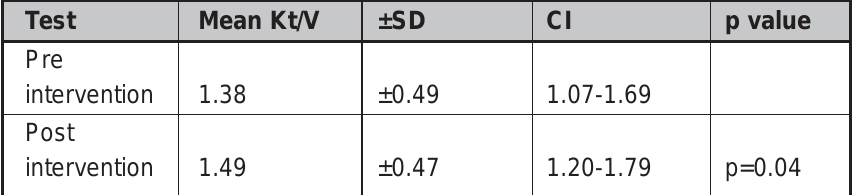
Table 3: Dialysis efficacy values (Kt/V) before and after the exercise intervention (n =